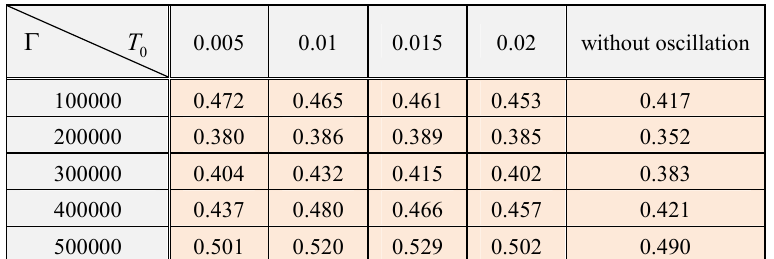
Table 1 Time averaged values of σ